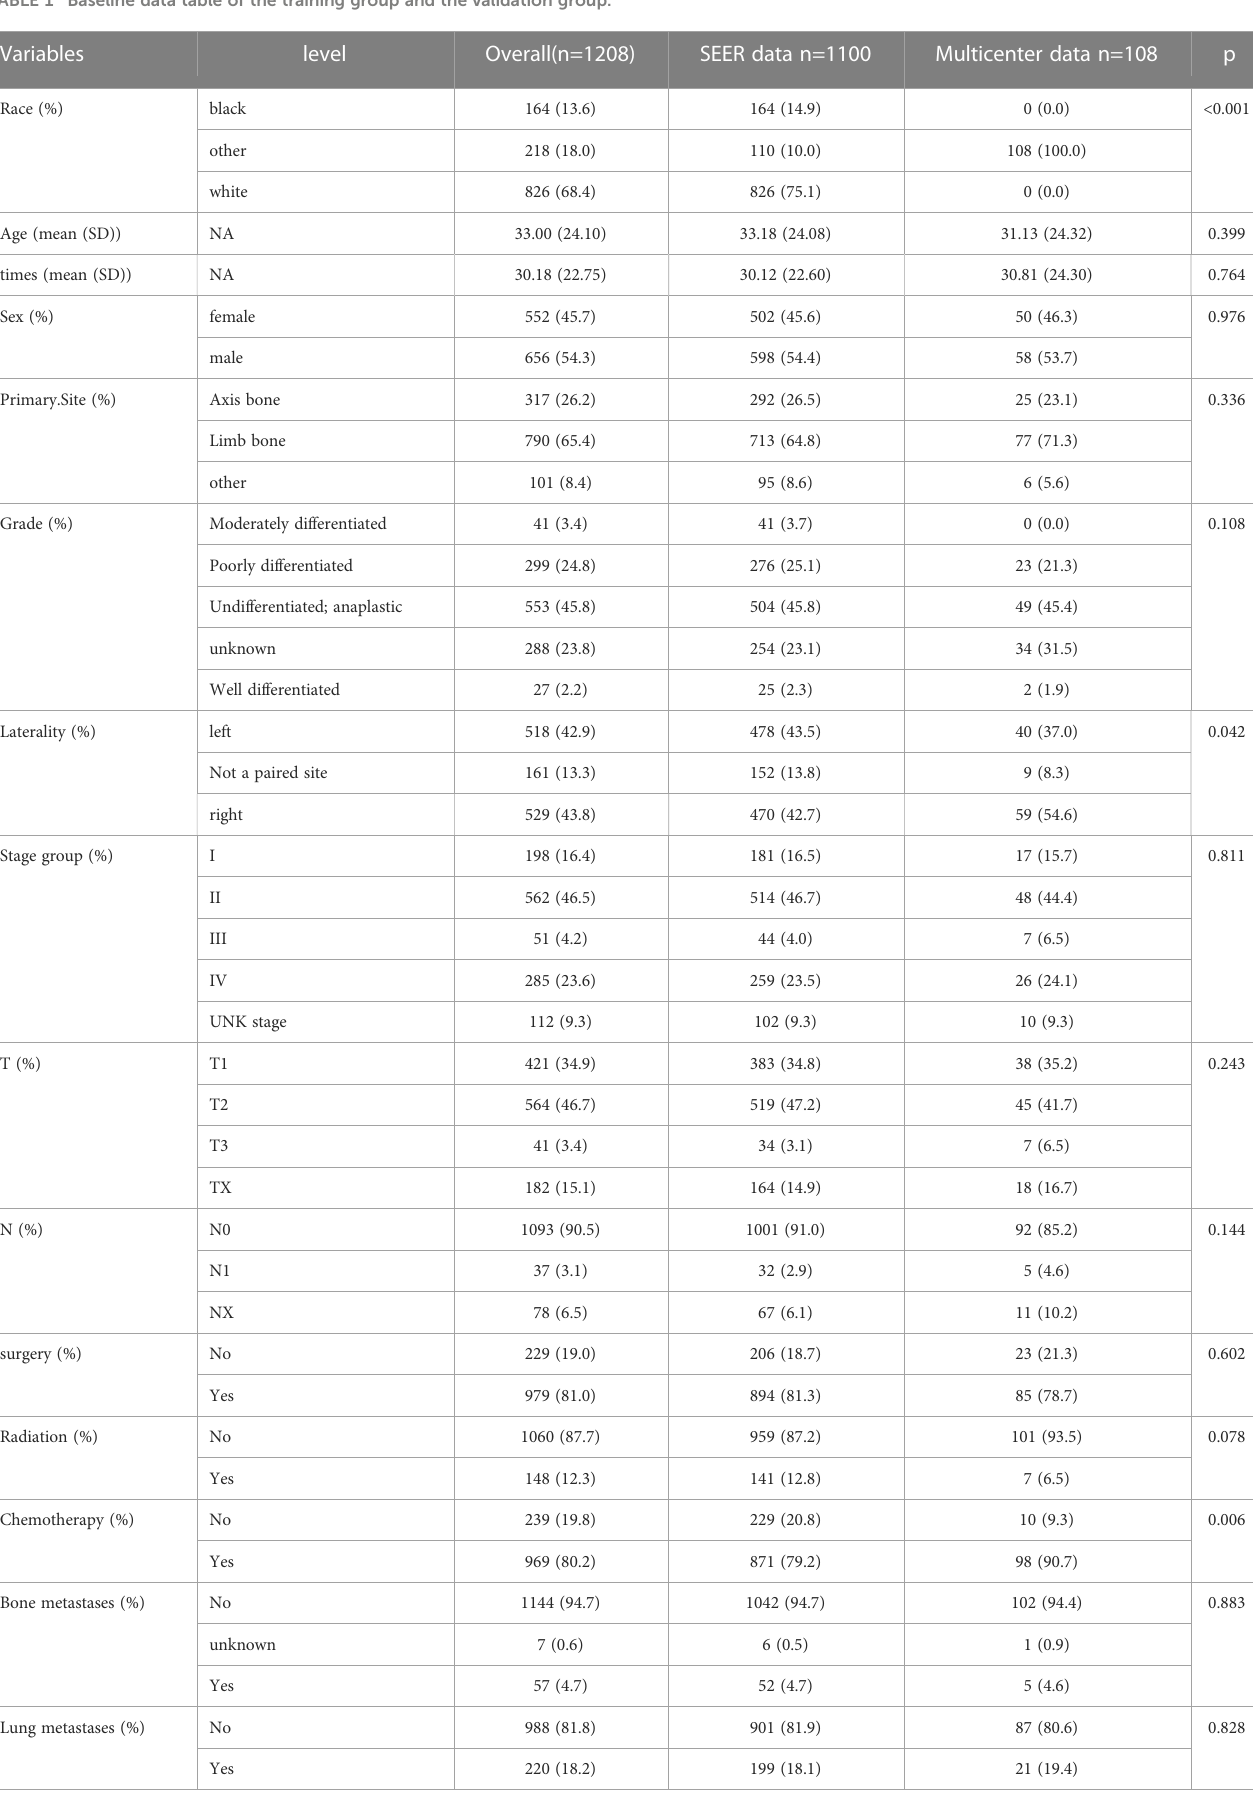
TABLE 1 Baseline data table of the training group and the validation